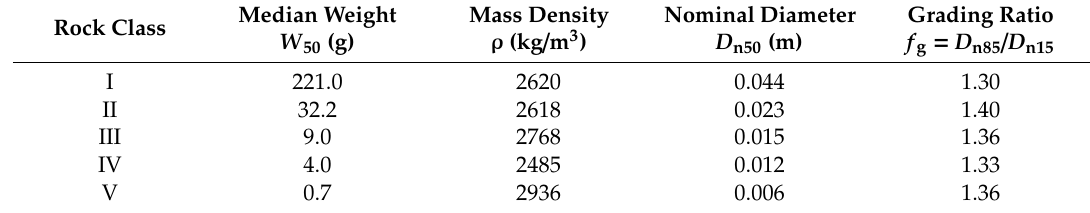
Table 2. Test materials used for all layer compositions.